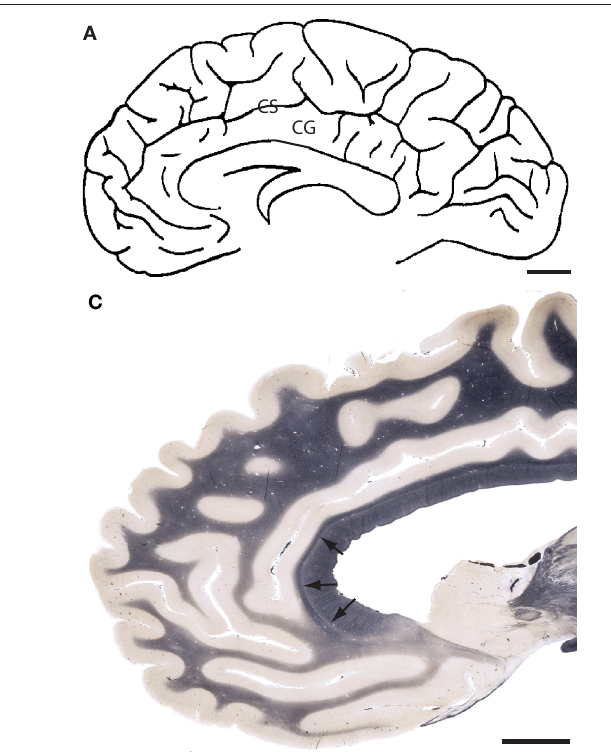
(24a,b,c,a ′ ,b ′ ,c ′ , respectively). (C) Human sagittal myelin stain showing the cingulate cortex and the cingulum bundle (arrows) as a thin fi ber tract overlying the corpus callosum. (D) The cingulum bundle in the rhesus monkey, as visualized with DTI. Panels (A,B) modifi ed from Vogt et al. (1995), and panel (D) from Schmahmann et al. (2007), with permissions. Scale bars 1